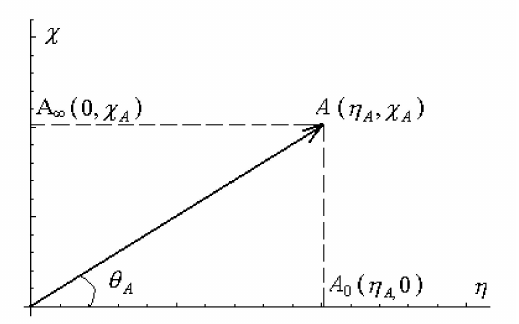
Figure 2. Cartesian representation of the η − χ (hardness-electronegativity) diagram for the electronic system A ( η A , χ A )